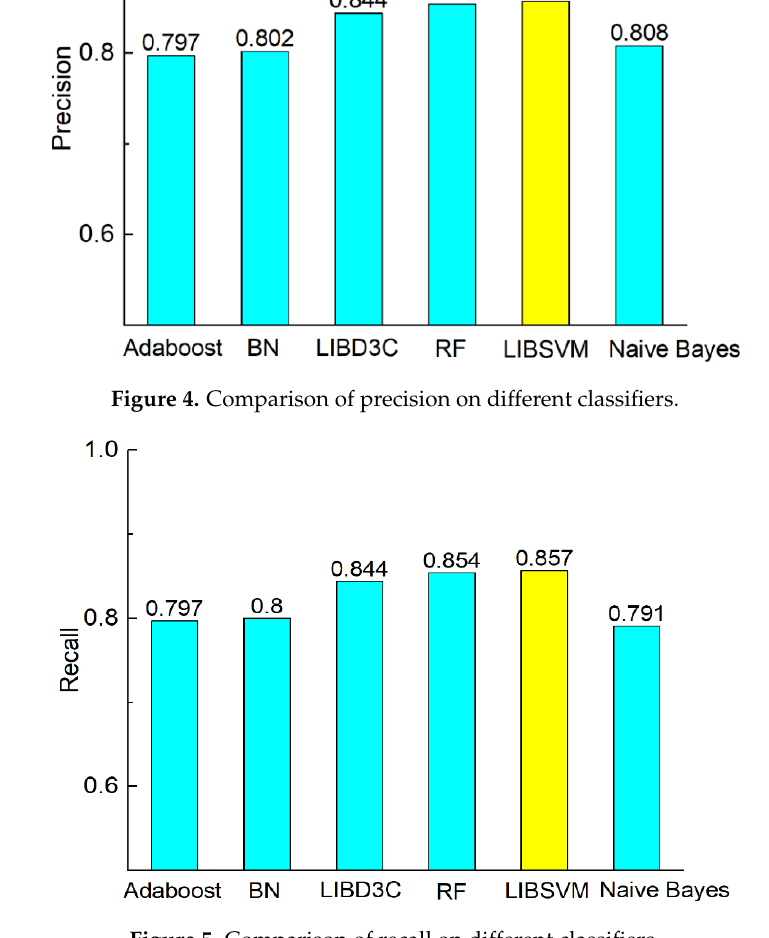
Figure 6. Comparison of F-measure on different classifiers.